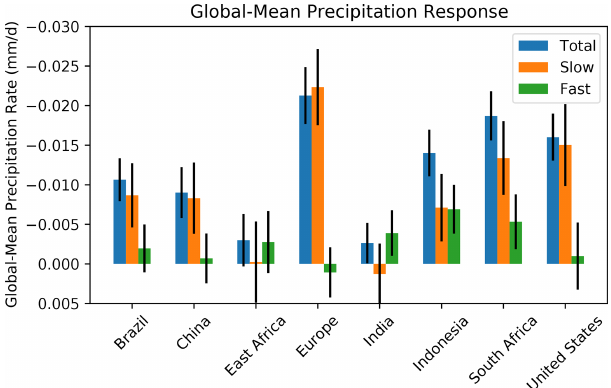
Figure 3. Decomposition of the global-mean total precipitation re- sponse (mmd − 1 , blue) to identical emissions from each of the eight regions into the slow (orange) and fast (green) precipitation re- sponse. Error bars provide the 95% confidence interval ( ± 1 . 96 σ